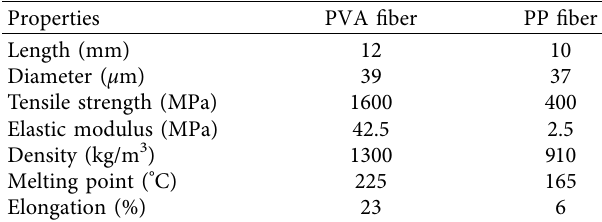
Table 1: Physical properties of PVA and PP